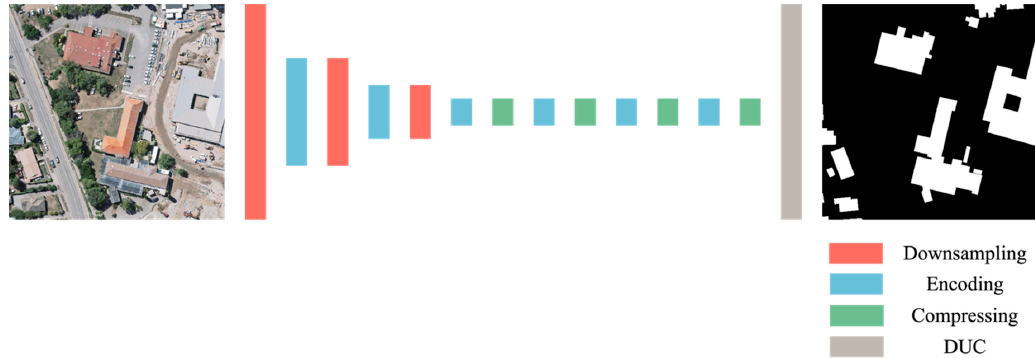
Figure 2. Overview of the Deep Encoding Network (DE-Net).